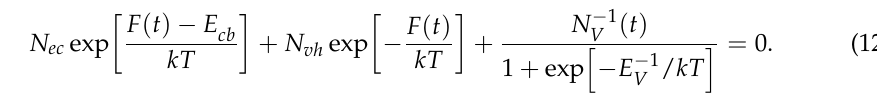
and entropy S , migration f f , where ν V